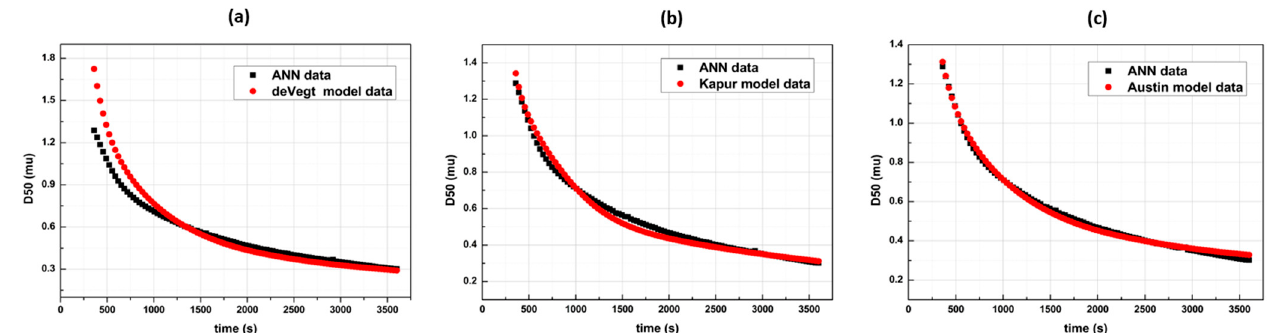
Figure 4. Result dynamic profiles for the three breakage functions ( a ) de Vegt function’s best fit curve generating a 0.89% MSE ( b ) Kapur function’s best fit curve generating a 0.08% MSE, and ( c ) the Austin function’s best fit curve generating a 0.02% MSE .